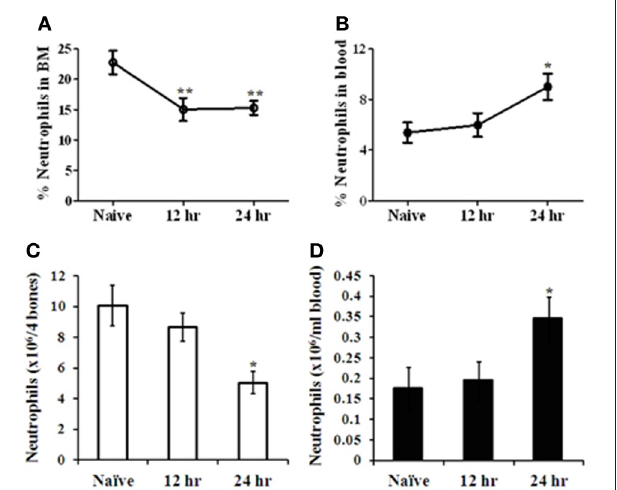
FIGURE 1 | Analysis of neutrophil mobilization from the BM to the blood at early stages of pneumonic plague. C57BL/6 mice were infected i.n. with 100 LD 50 (100,000cfu) of the virulent Y. pestis strain Kim53. The percentage of neutrophils (Gr-1 high /CD11b + ) in the BM (A) and the blood (B) was quantified by flow cytometry. The absolute number of neutrophils was calculated per 4 bones (C) and per 1ml blood (D) at the indicated time points post i.n. infection. n = 8–12 mice per group. ∗ p < 0 . 05; ∗∗ p < 0 . 01 compared with naïve